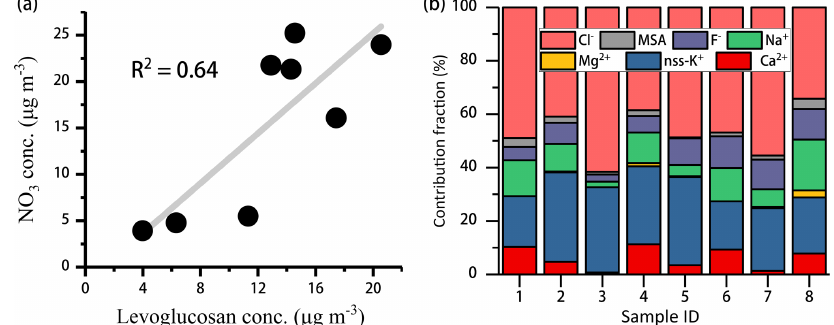
Figure 2. (a) Correlation analysis between the mass concentrations of levoglucosan and aerosol nitrate during the Sanjiang sampling cam- paign; (b) variation of fractions of various inorganic species (MSA − stands for methyl sulphonate) during day–night samplings at Sanjiang between 8 and 18 October 2013 (sample ID 1 to 8). The higher relative abundances of nss-K + and Cl − are indicative of a biomass-burning- dominated source. For sample ID information and exact sampling dates, refer to Table S3.